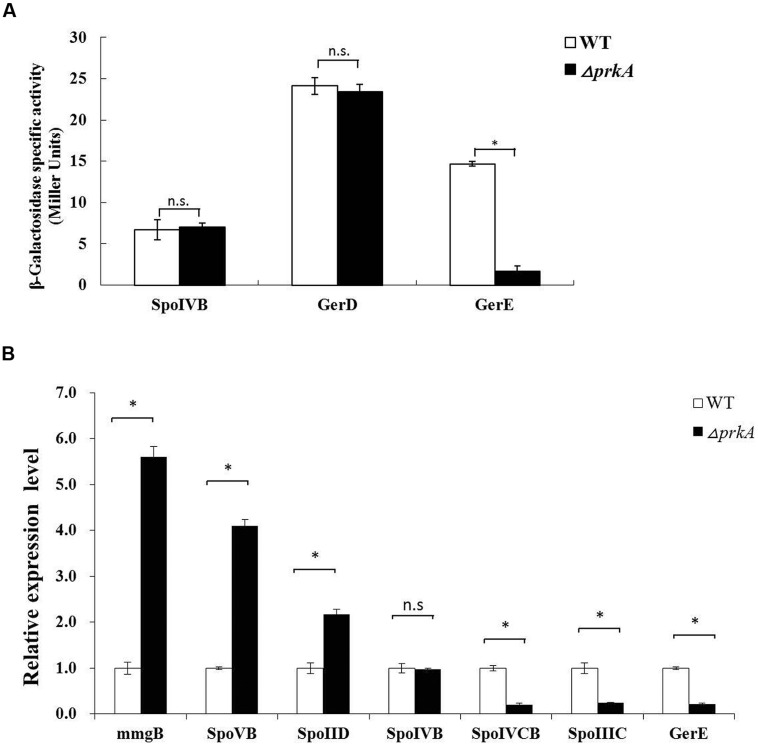
PrkA decreases the expression of the transcriptional factor σK and its target genes. (A) Assay to β-galactosidase activity in the reporter gene fusion expression strains. The white histogram bar represents the WT strain, and the black bar represents ΔprkA mutant. (B) Real-time PCR to detect the relative expressional level of the typical sporulation-related genes, including mmgB, spoIID, spoVB, spoIVB, gerD, and gerE. The white histogram bar represents the WT strain B. subtilis 168, and the black bar represents ΔprkA mutant. ∗P < 0.01; n.s represented no statistical significance.